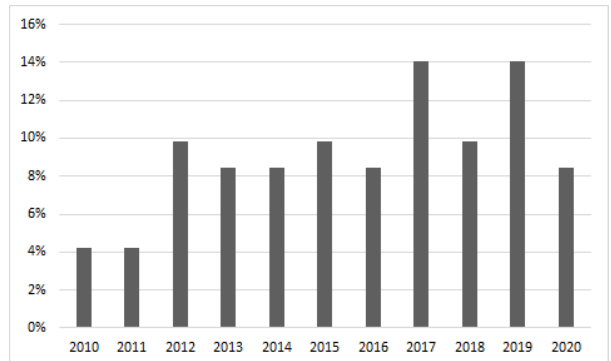
Figure 1. Distribution of reviewed papers across the selected time span (for 2020, only the first half of the year was taken into